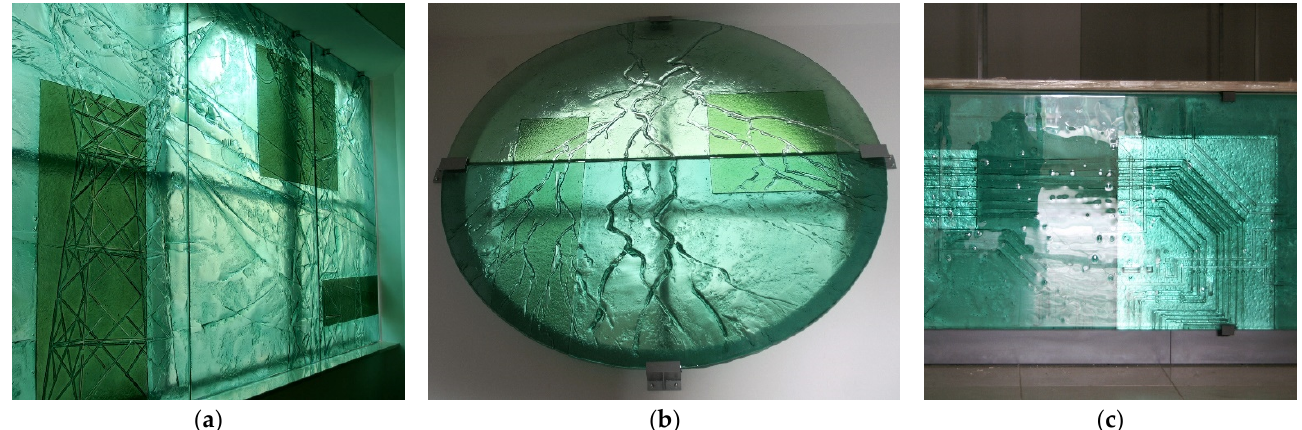
Figure 21. Completed compositions with predominant green tones: ( a ) medium- and high-current representations in kiln-formed glass; ( b ) lightning depiction in artistic glass; ( c ) glass panels of the reception desk with rectangular mirror inserts (Tomasz